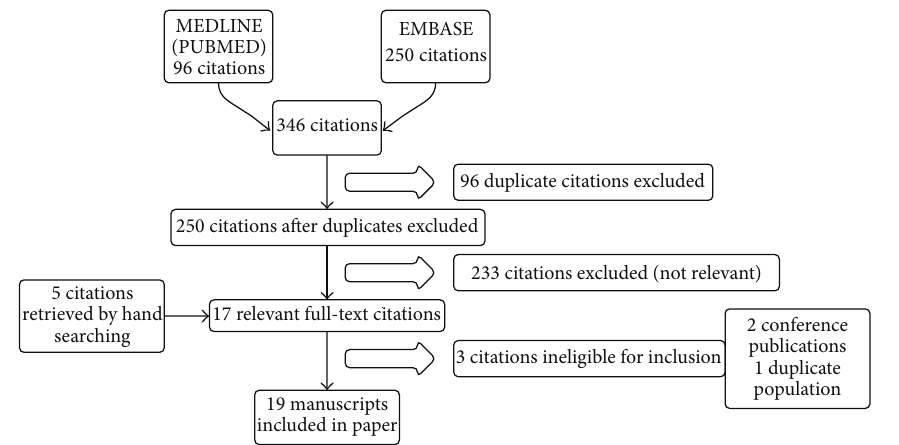
Figure 1: Flowchart of study selection.